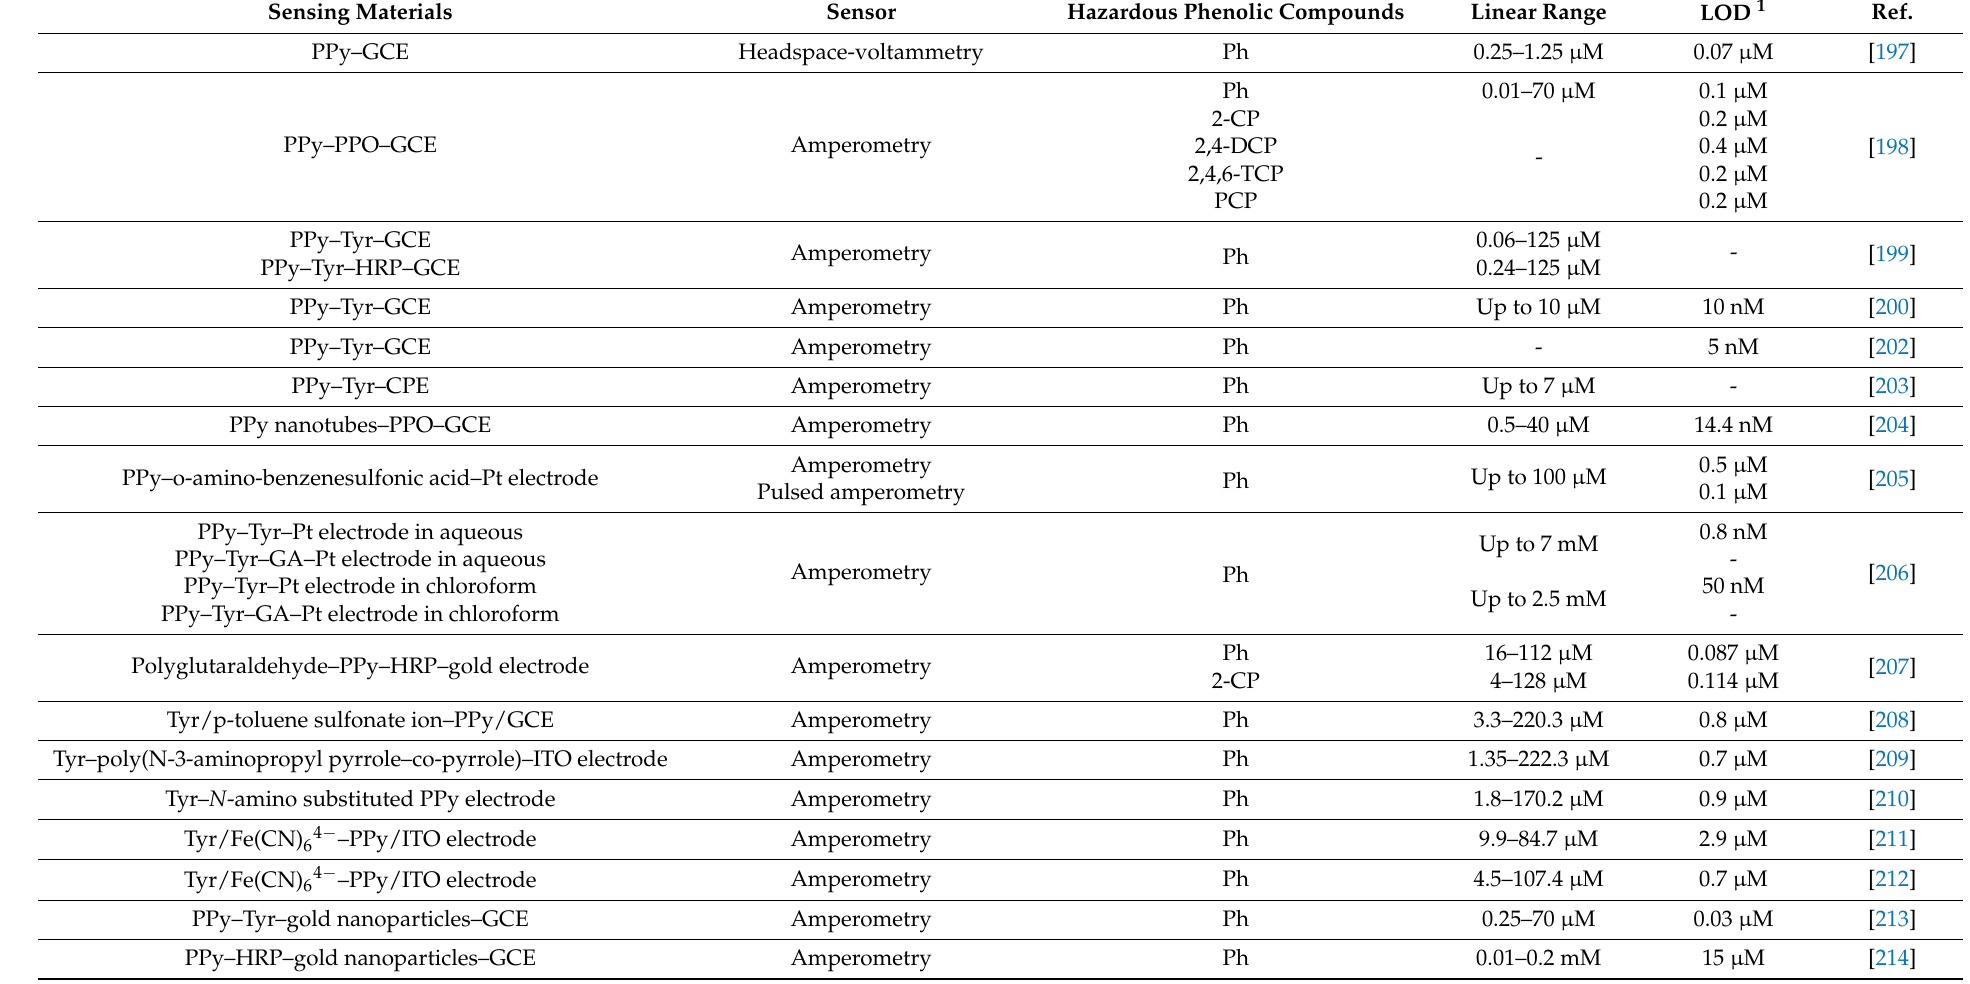
Table 5. PPy-based materials incorporated with electrochemical sensors for hazardous phenolic compounds